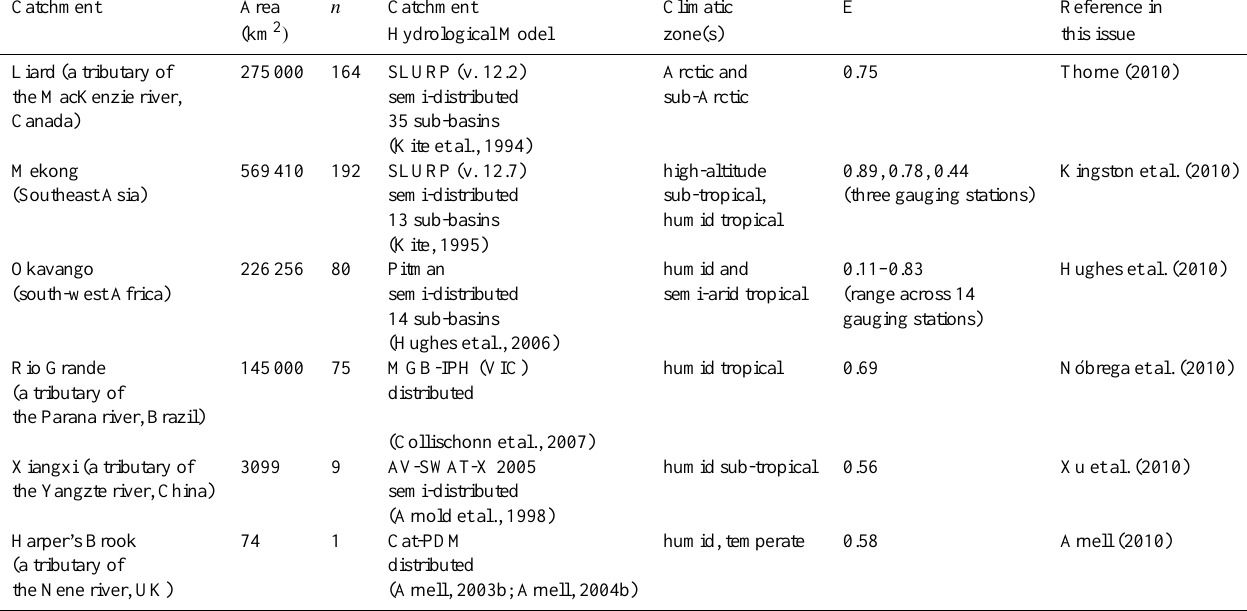
Table 1. List of the catchments and their characteristics included in this study and the CHMs applied to each respective catchment. References for the re-calibrated version of each CHM applied in this study are given in the far right column, next to the the Nash-Sutcliffe model efficiency coefficients ( E ) (Nash and Sutcliffe, 1970) that were calculated in validation exercises presented by those studies. n denotes the number of 0.5 ◦ × 0.5 ◦ model grid cells located within each